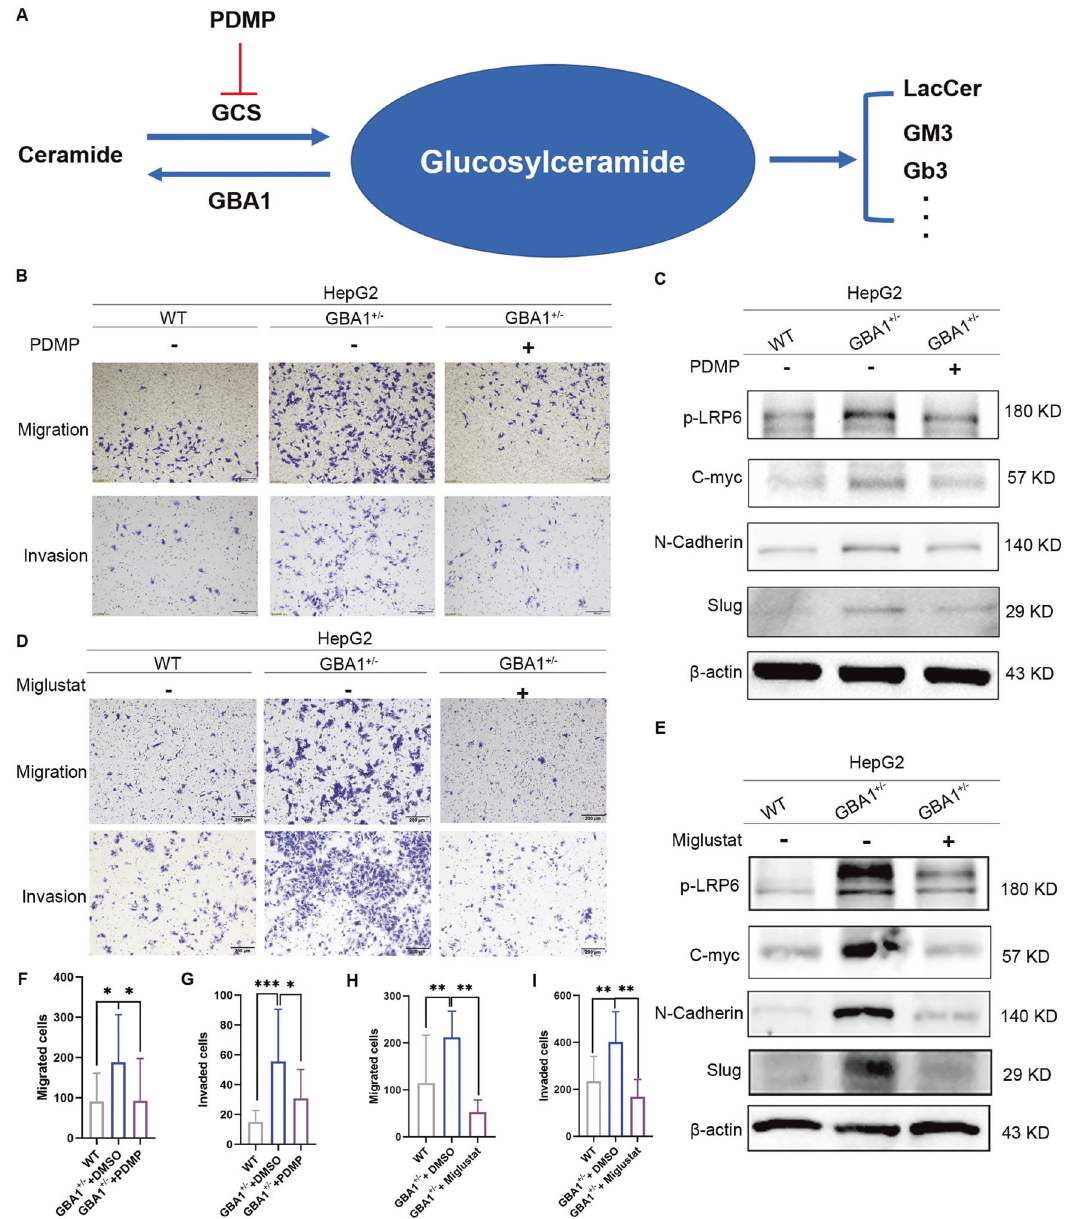
C , E Western blotting was performed to determine the effect of PDMP or miglustat on GBA1 de fi ciency-upregulated proteins involved in the Wnt signalling pathway and EMT. F – I The relative number of migrated cells ( F , H ) and invaded cells ( G , I ) is